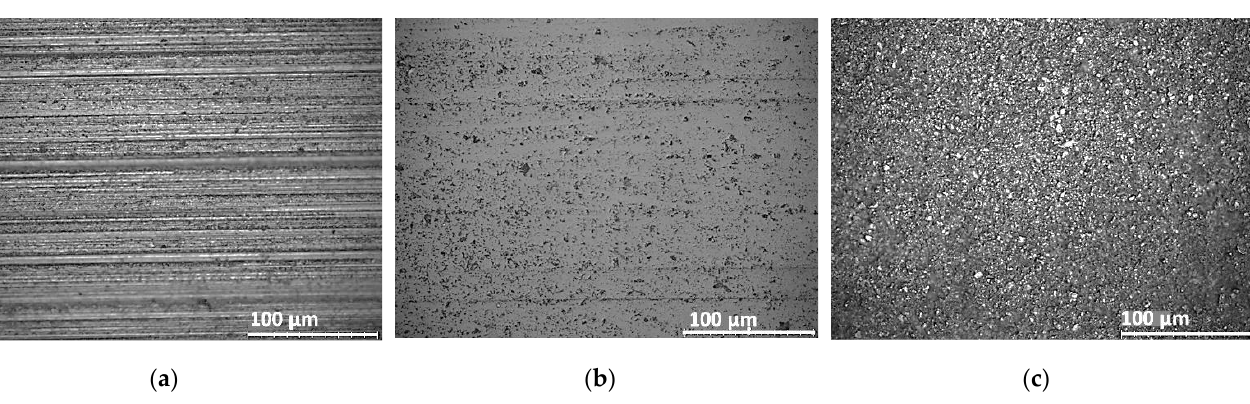
Figure 2. Surface topography before coating process, observed through an optical microscope: ( a ) conventional machined shim; ( b ) diamond-polished shim; and ( c ) grit-blasted shim.